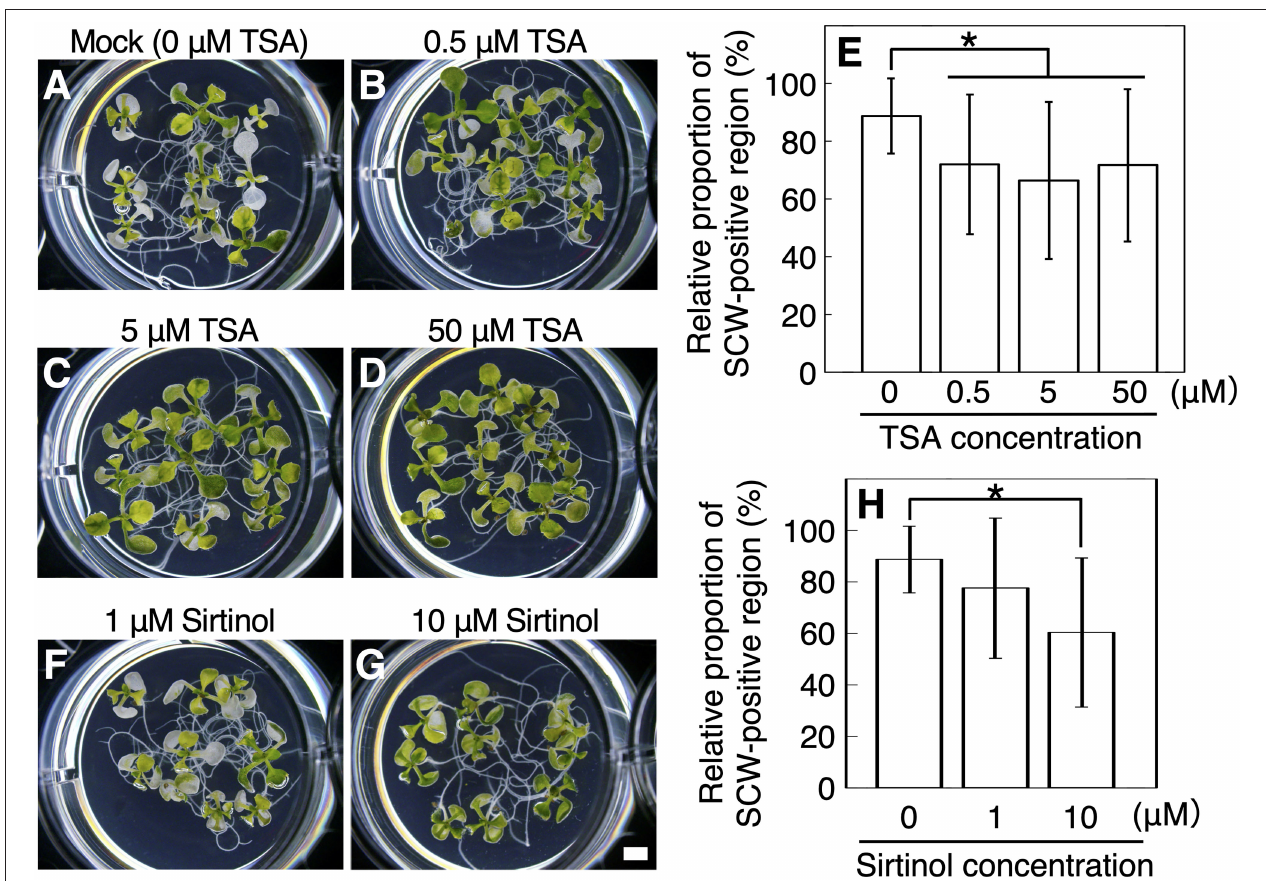
FIGURE 1 | Histone deacetylase inhibitors inhibit VND7-based xylem vessel cell differentiation. (A–E) Seven-day-old VND7–VP16–GR seedlings were soaked in the distilled water with 10nM dexamethasone (DEX) and 0 µ M (A) , 0.5 µ M (B) , 5 µ M (C) , or 50 µ M (D) trichostatin A (TSA) for 3 d. (F–H) The VND7–VP16–GR seedlings were treated with 10nM DEX and 1 µ M (F) or 10 µ M (G) sirtinol, and incubated for 3 d. (E,H) Ectopic deposition of secondary cell walls (SCWs) in cotyledons was observed with a confocal microscope after propidium iodide staining, and the SCW-positive regions were measured in each cotyledon. The relative proportions of SCW-positive cell regions were calculated manually using an image analysis performed in ImageJ. Results are shown as means ± SD ( n > 10). Asterisks indicate statistically significant differences compared with the mock control (Student’s t -test, p < 0.05). Bar,